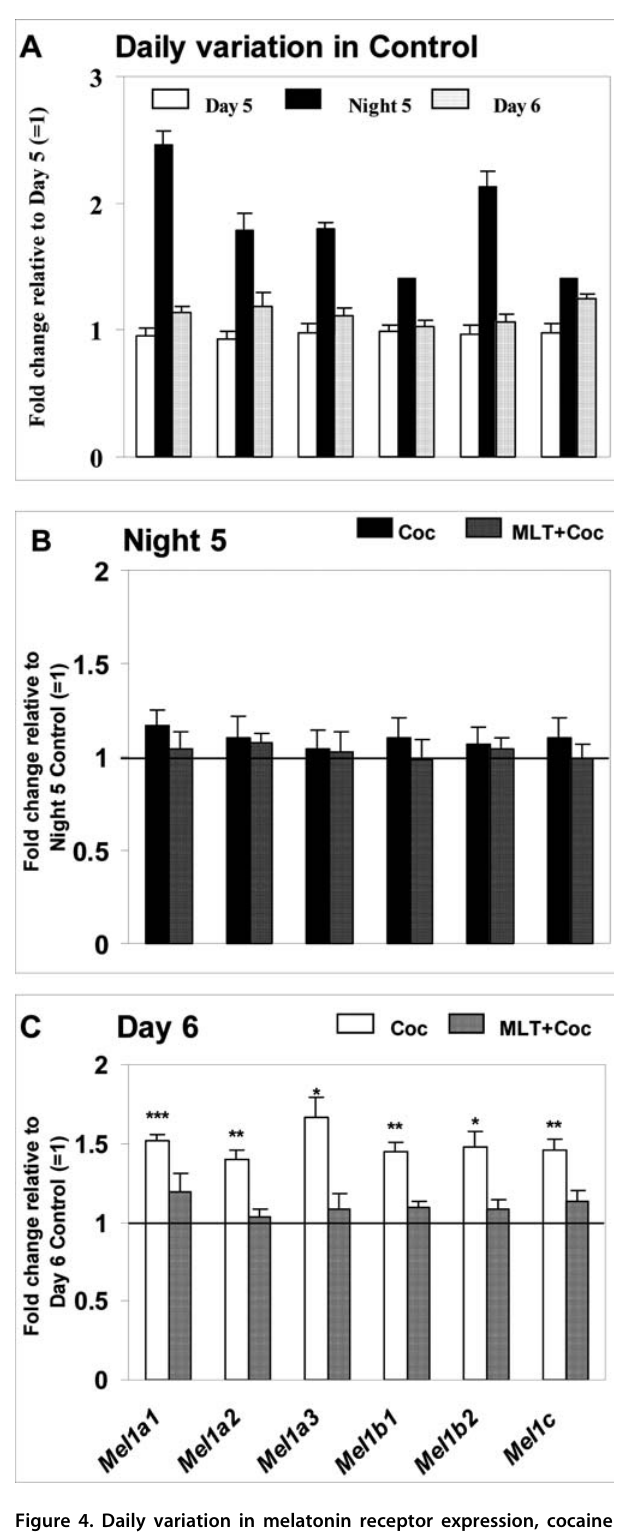
Figure 4. Daily variation in melatonin receptor expression, cocaine efficacy and ability of melatonin to counteract the effects of cocaine are preserved during early postnatal period in zebrafish. (A) Normal daily pattern of mRNA expression for six melatonin receptors on Day 5, Night 5 and Day 6 post-fertilization in Control group, fold change expressed relative to Day 5 (=1). (B) Change in melatonin receptor expression following Daytime cocaine administration alone (Coc) or following melatonin pre-treatment (MLT + Coc) at 6 dpf, relative